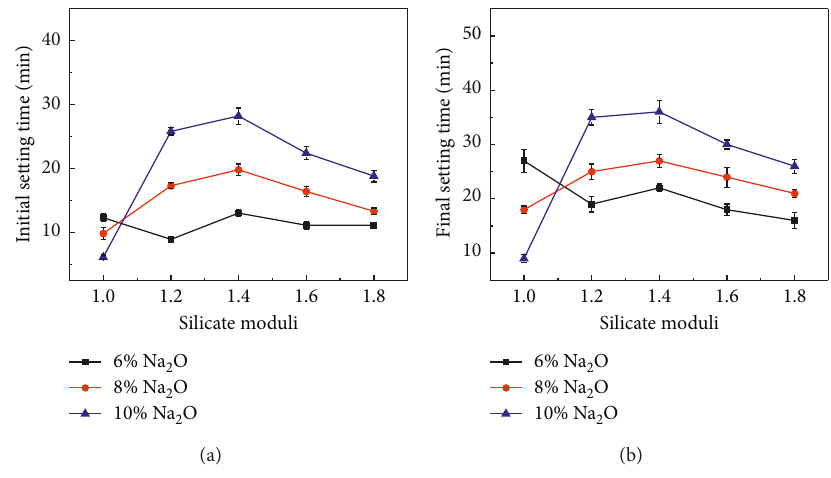
Figure 1: The setting times of AAS pastes: (a) initial setting time; (b) final setting time.